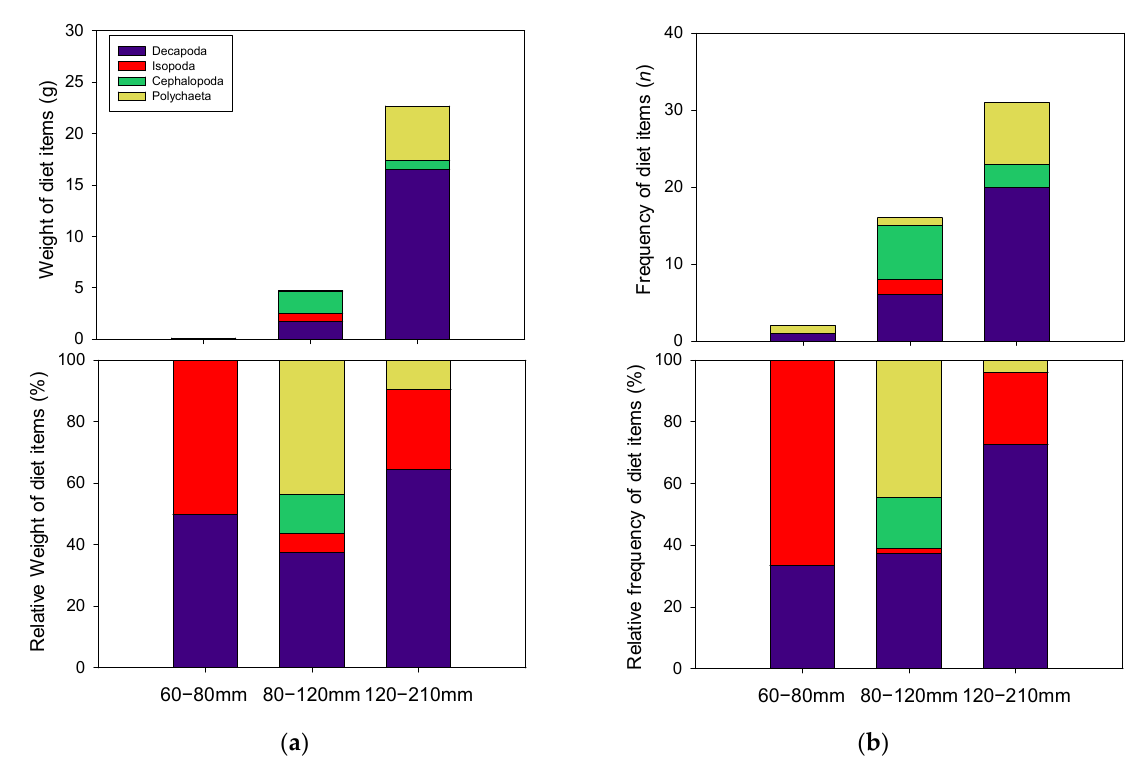
Figure 4. Stomach contents in each size class of P. argentata . ( a ) indicates contribution based on total weight and percentage of contents, and ( b ) indicates dietary contribution based on frequency and percentage of contents.